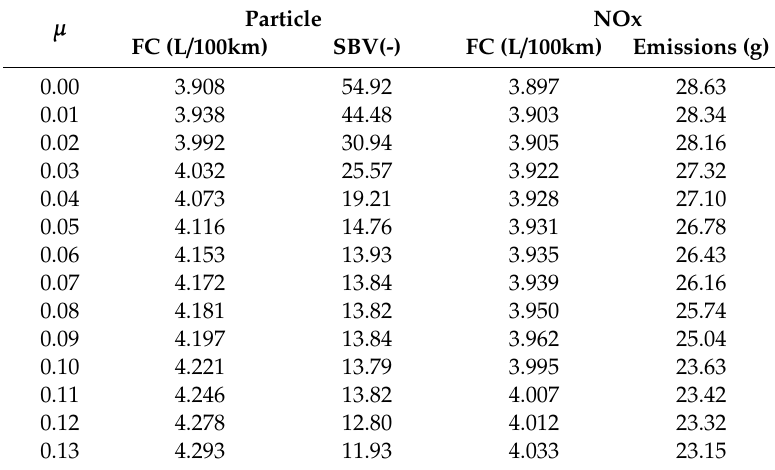
Figure A4. The variation curves of SOC pertaining to di ff erent µ for emission particle. Table A1. The combination of simulation results of the series of discrete values µ .